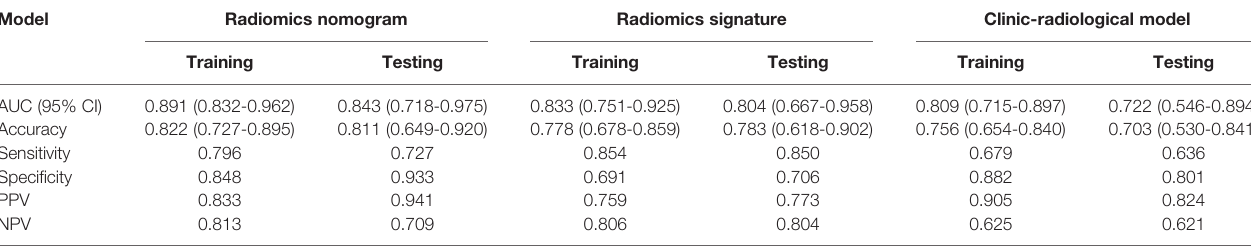
TABLE 4 | Predictive performance of clinic-radiological model, radiomics signature, and radiomics nomogram.